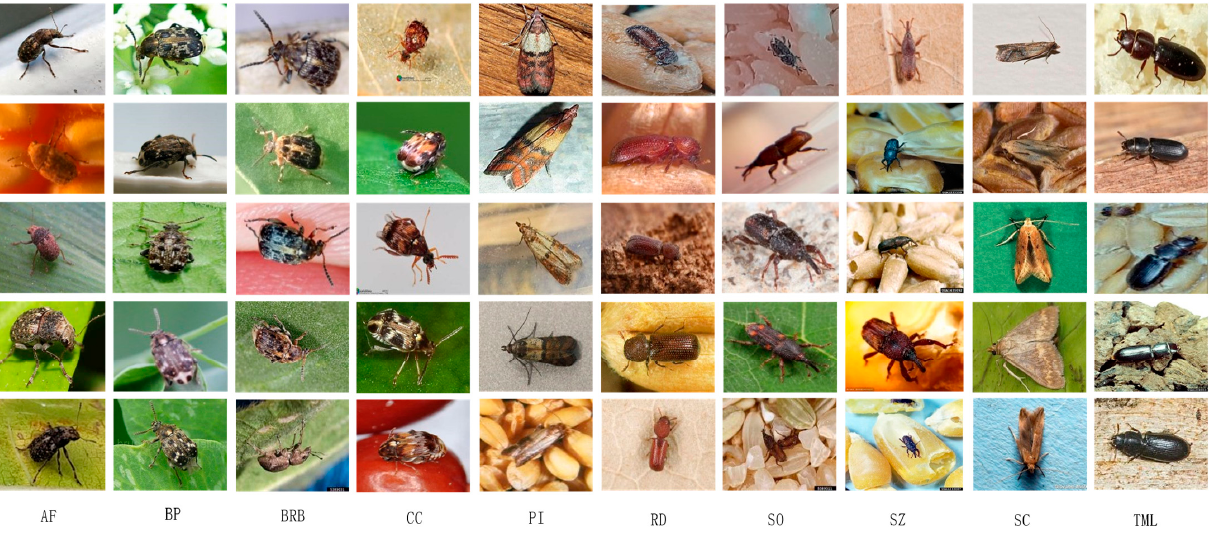
Figure 4. Sample images collected in GP10.